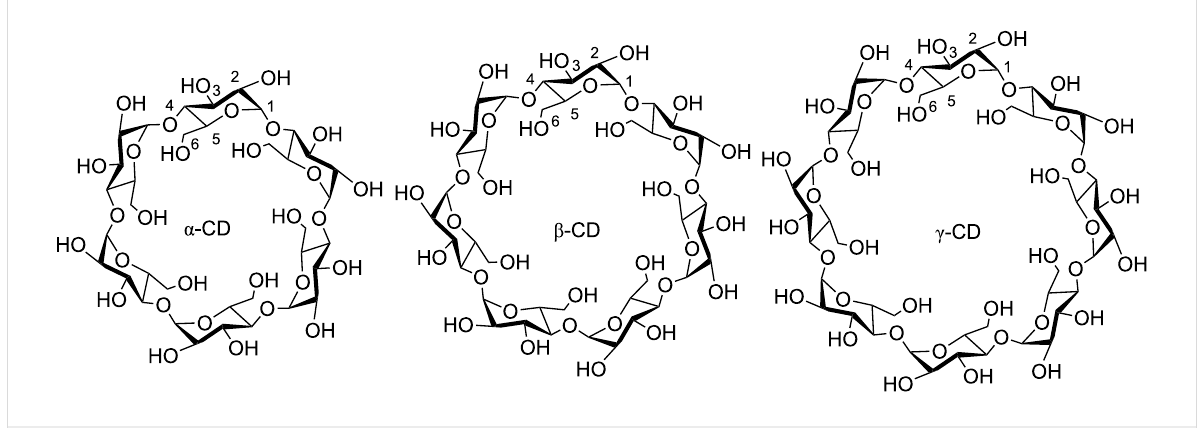
Figure 1: Structures of α -, β - and γ -CD. Individual carbon atom numbering is shown for one D-glucopyranose subunit in each structure.